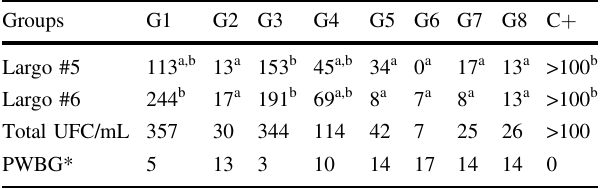
Table 2 Amount of CFU/mL per group for samples performed with Largo #5 (L5) and Largo #6 burs (L6), amount of total CFUs and amount of plates that did not present bacterial